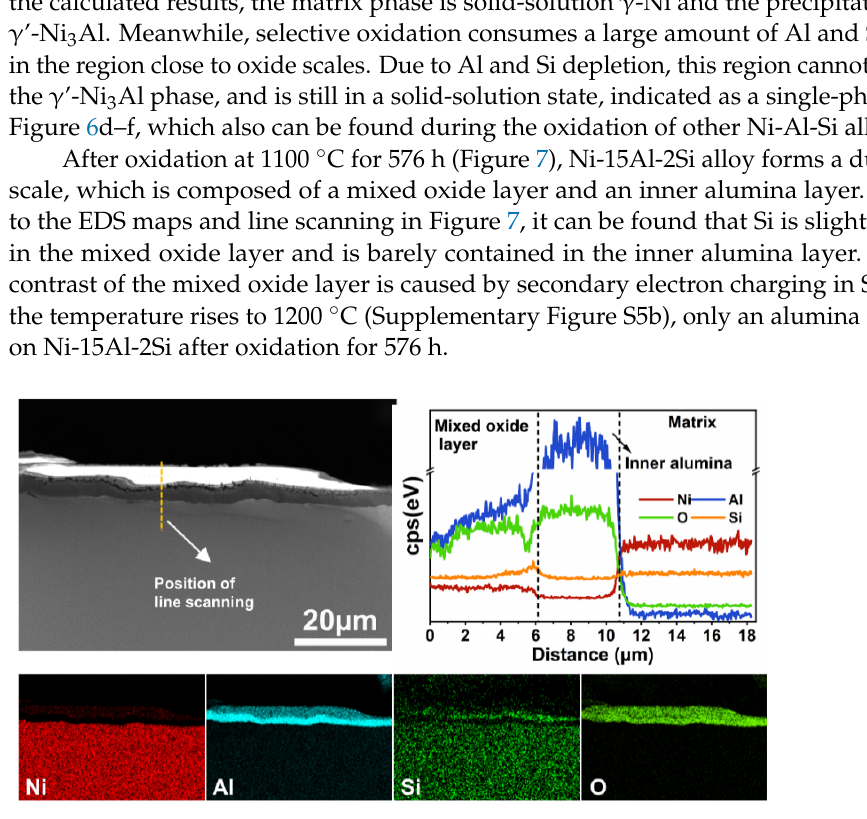
Figure 7. Cross-sectional microstructure (SE images), corresponding EDS maps, and line analysis of oxide scale on Ni-15Al-2Si alloy oxidized at 1100 °C for 576 h. Note that Si element is slightly enriched in the mixed oxide layer.